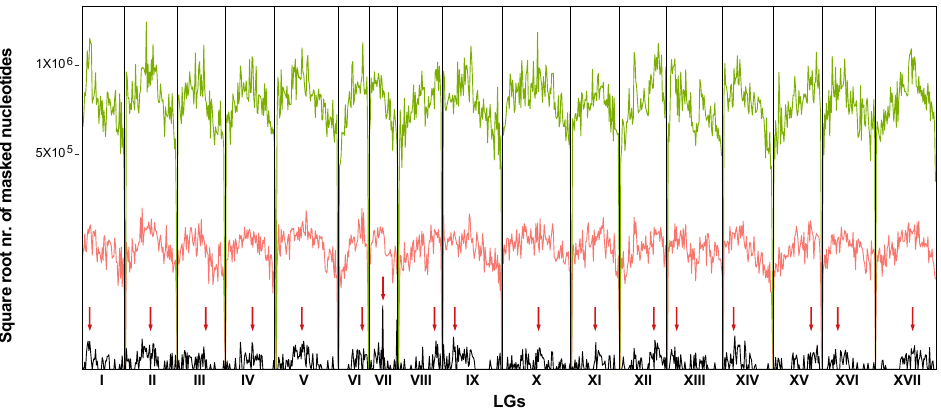
Figure 4. Distribution of the Gypsy (in green) and Copia (in red) LTR-RE families along the 17 linkage groups (LGs) of the sunflower genome (line HanXRQ [42]). The distribution of a putative centromeric sequence ([58], in black) is also reported. Red arrows indicate the most probable centromere position of each LG, corresponding to the peaks of highest frequency of the putative centromeric